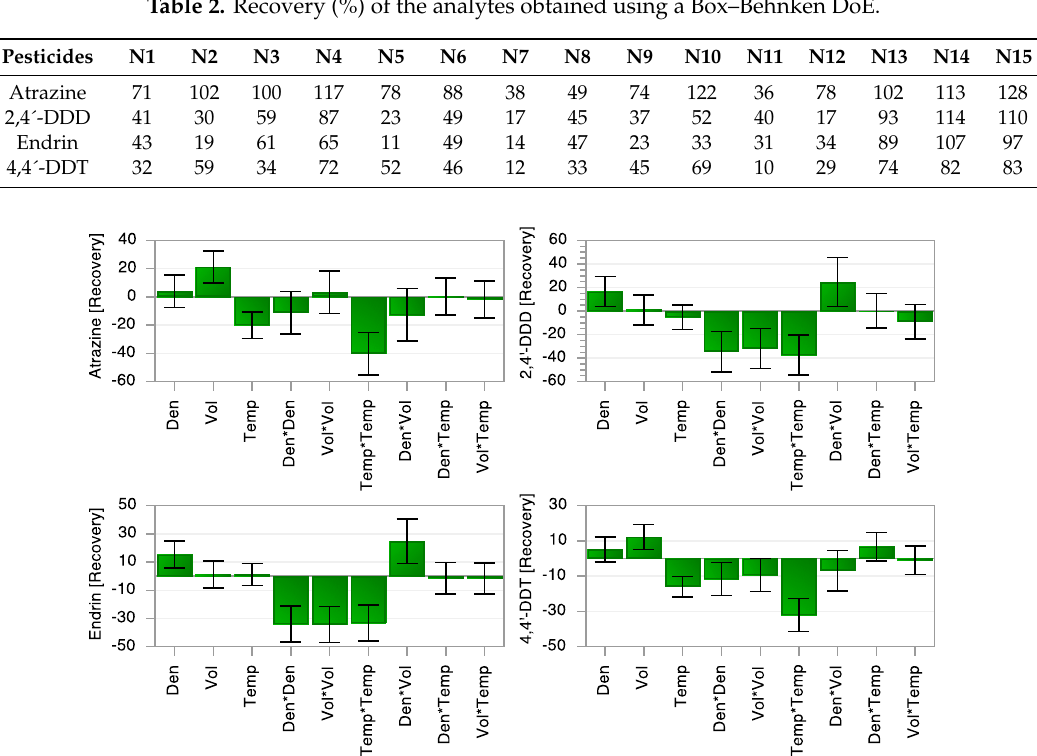
Table 1. Surface response Box–Behnken experimental design of variables for optimization of SFE method.